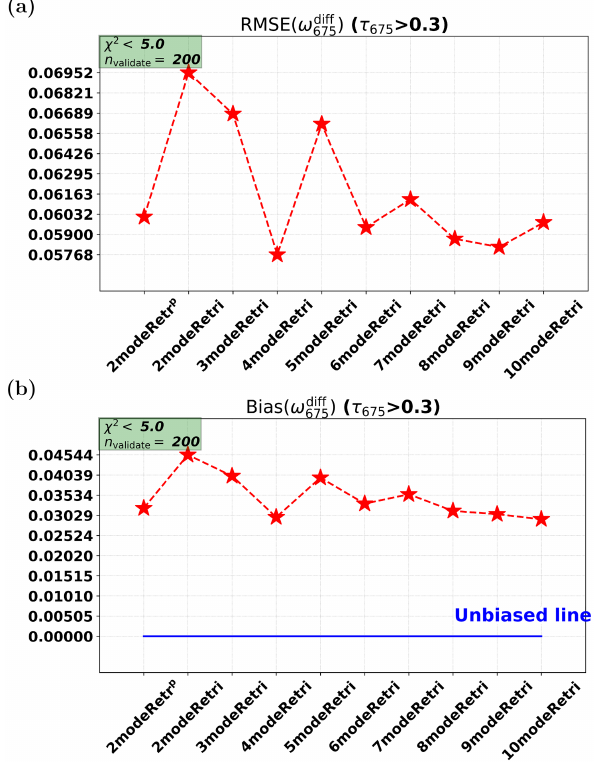
Figure 16. Real data retrievals for SSA: root-mean-square error (RMSE) and bias for the difference between PARASOL retrievals and AERONET